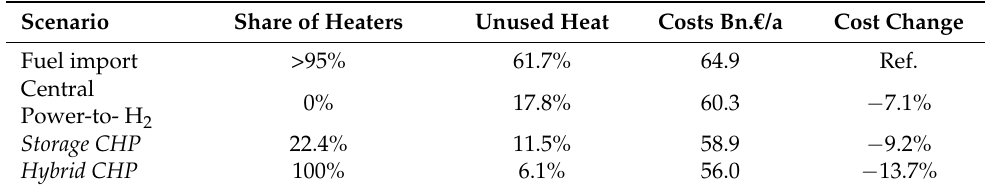
Table 1. Lost heat and cost reductions. Fuel imports for comparison as